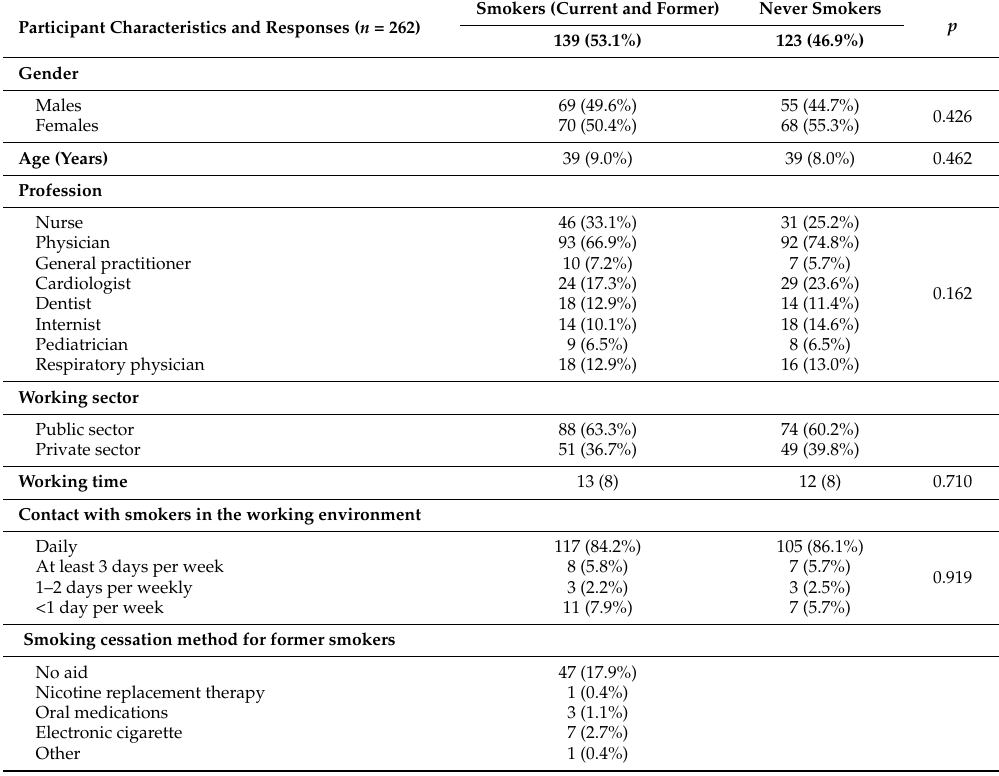
Table 2. Comparison of survey responses between smokers (current and former) and never-smokers.